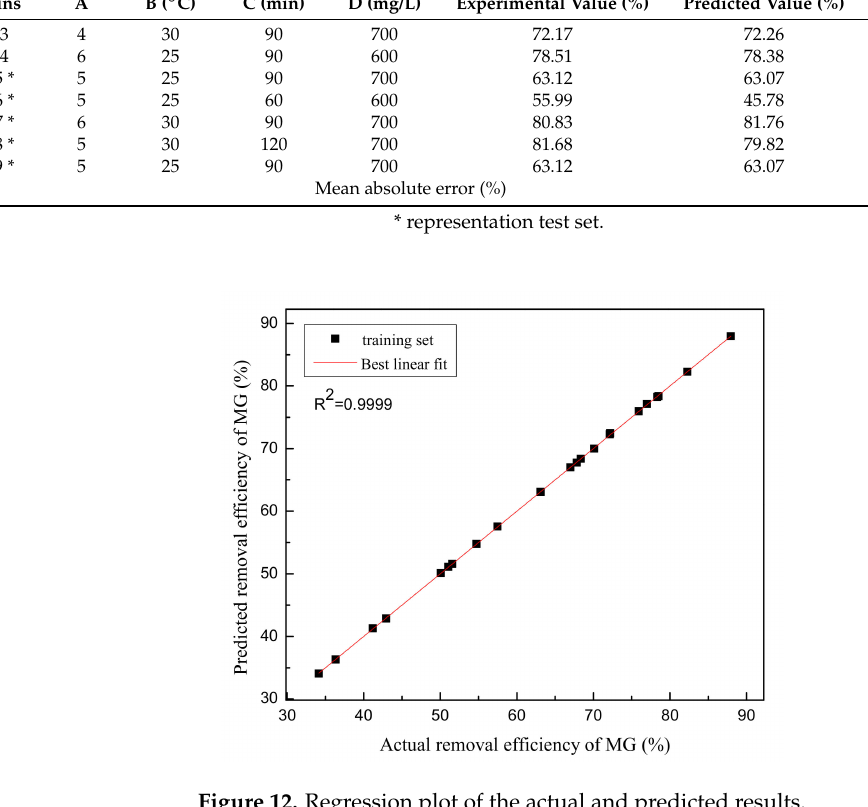
Figure 12. Regression plot of the actual and predicted results.